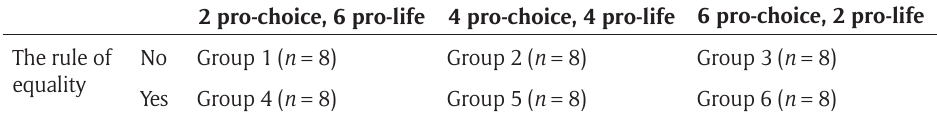
Opinion diversity within a group